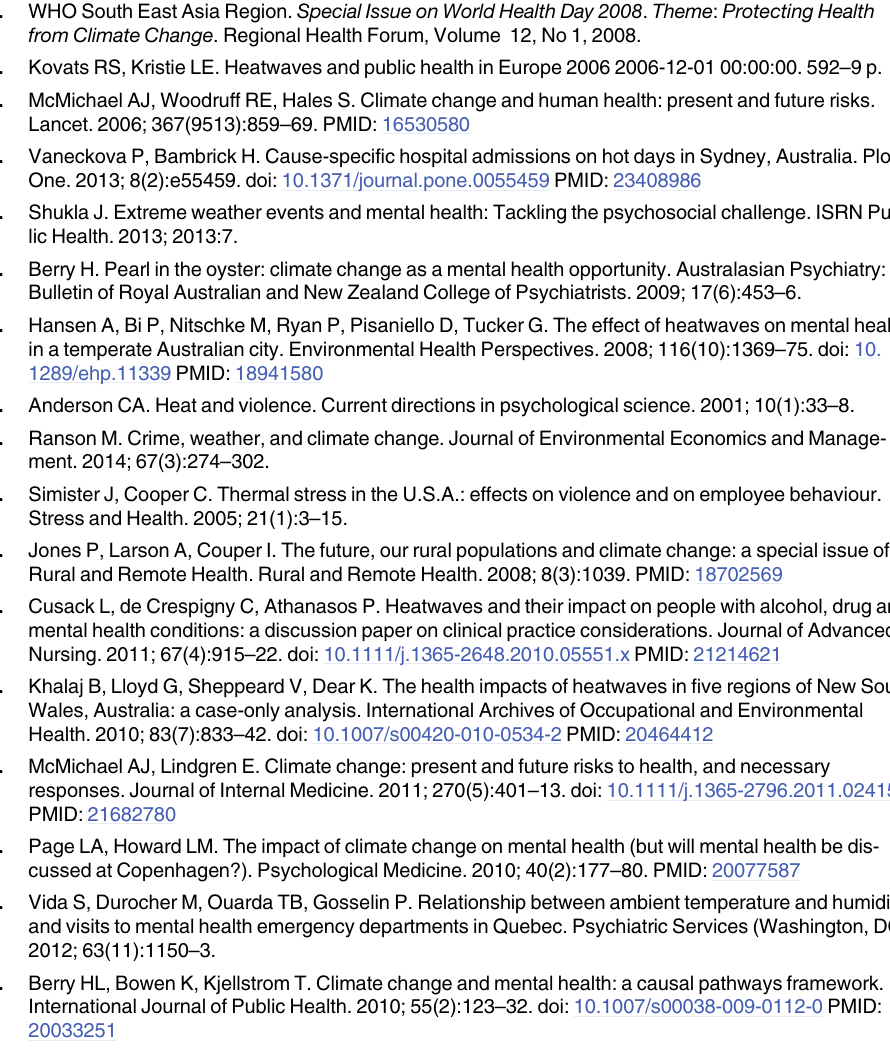
S1 Table. Dataset (Excel